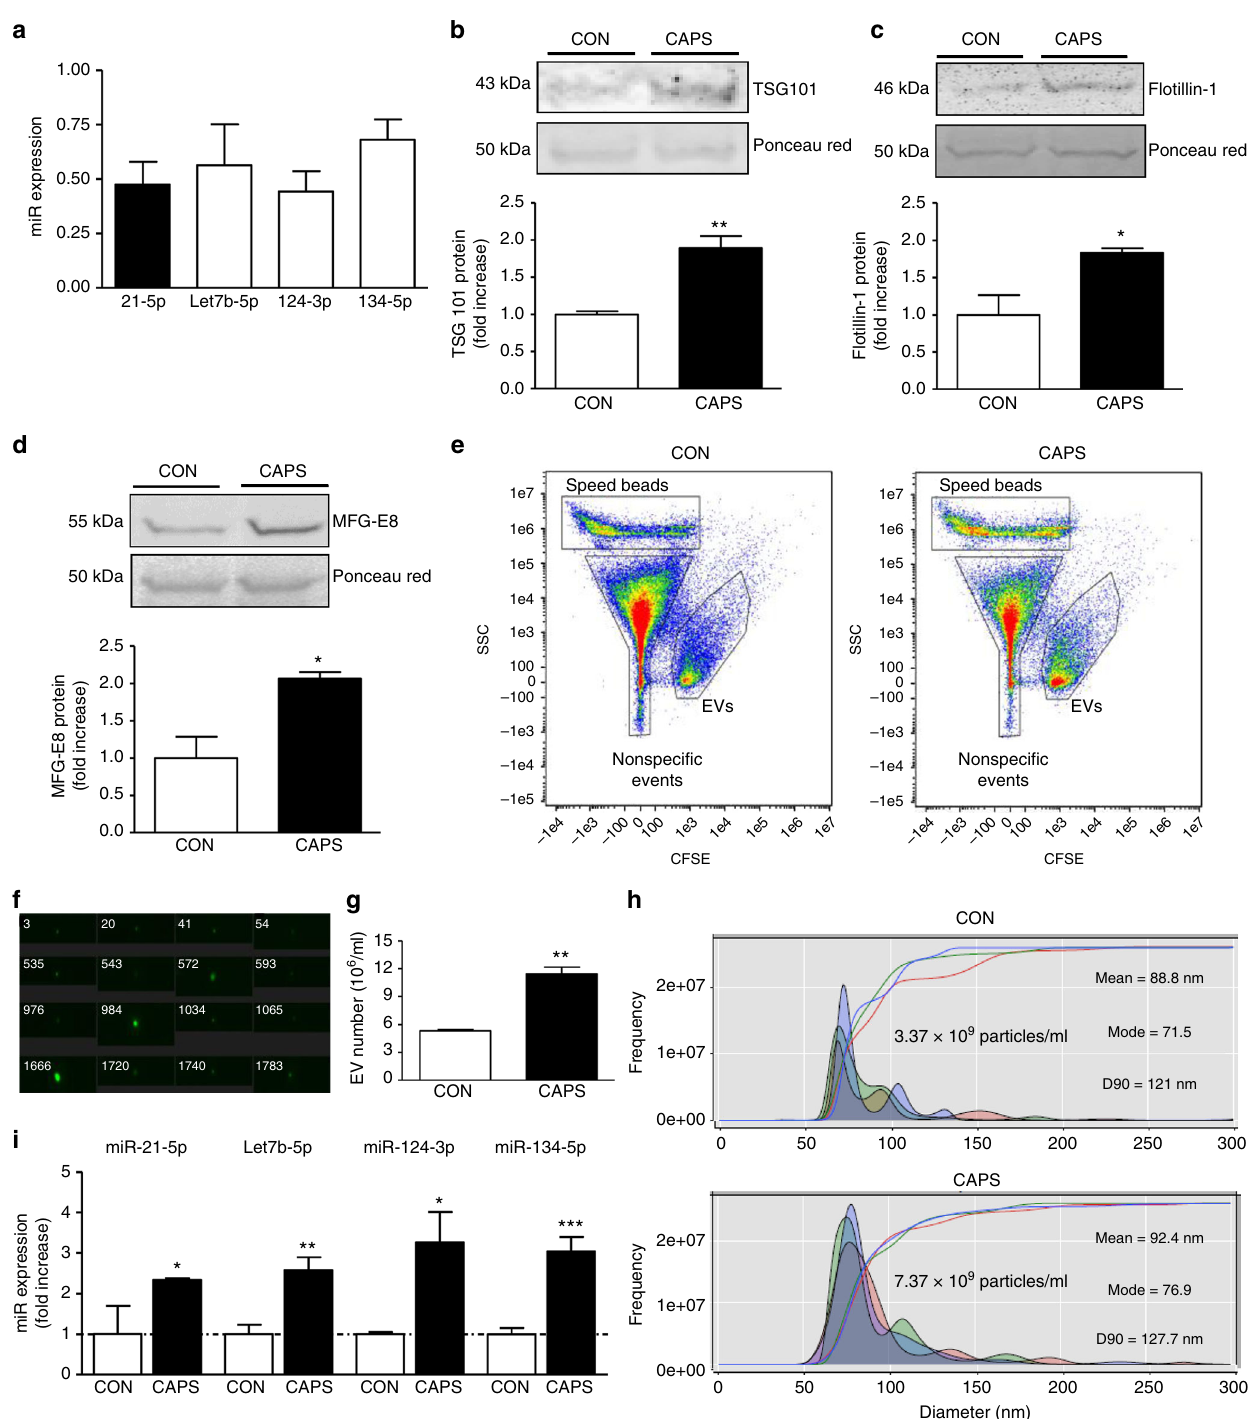
Fig. 2 Capsaicin induces release of extracellular vesicles that include exosomes containing miRs from sensory neurons in culture. a Intracellular expression of miRs 21-5p, Let7b-5p, 124-3p, and 134-5p normalized to SNORD 202 (housekeeping non-coding RNA; n = 5 cultures). b – d Representative western blot and quanti fi cation of exosomal markers TSG101, Flotillin-1, and MFG-E8 in the culture media of DRG neurons incubated with buffer control (0.001% dimethyl sulphoxide (DMSO) in HEPES buffer + glucose 1 mg/ml; CON) or Capsaicin (1 µ M; CAPS) for 3 h. Data are means ± S.E.M., n = 4 cultures; * P < 0.05 and ** P < 0.01 compared to control, Student ’ s t- test. e – g ImageStream ™ analyses. e Pseudocolour dot plots of carboxy fl uorescein succinimidyl ester (CFSE) fl uorescence against side scatter (SSC) for EVs isolated from culture media of neurons incubated with buffer control or CAPS for 3 h. f , g Representative images and quanti fi cation of EVs. Data are means ± S.E.M., n = 4 cultures; ** P < 0.01 compared to control, Student ’ s t -test. h NanoSight detection of exosomes isolated from culture media of neurons incubated with buffer control or CAPS for 3 h. Representative outcome is shown. Each colored line represents a single frame recording with a total of 3 frames for each sample. The inset data indicate mean diameter, mode diameter and D90 values represent the diameter of 90% of the particles. i Expression of miRs 21-5p, Let7b-5p, 124-3p and 134-5p in the exosomal fraction of DRG neurons media treated with buffer control or CAPS for 3 h. Data are means ± S.E.M., n = 4 cultures; * P < 0.05, ** P < 0.01 and *** P < 0.001 compared to control, Student ’ s t